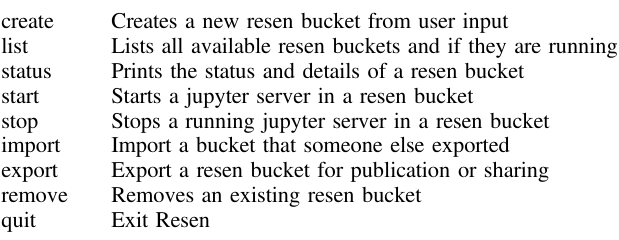
Table 1. Resen commands.